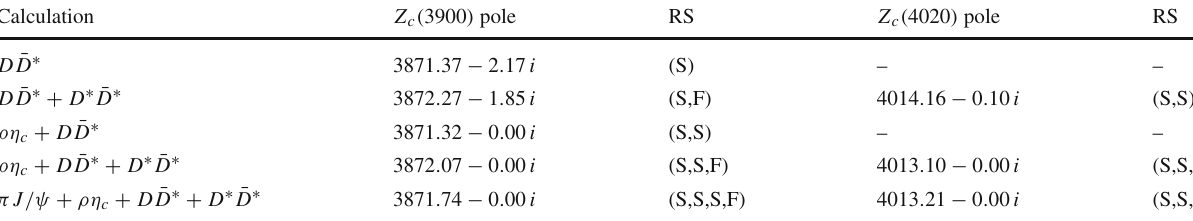
Table 2 The S -matrix pole positions, in MeV/c 2 , for different coupled- channels calculations. The included channels for each case are shown in the first column. Poles are given in the second and fourth columns by the value of the complex energy in a specific Riemann sheet (RS).